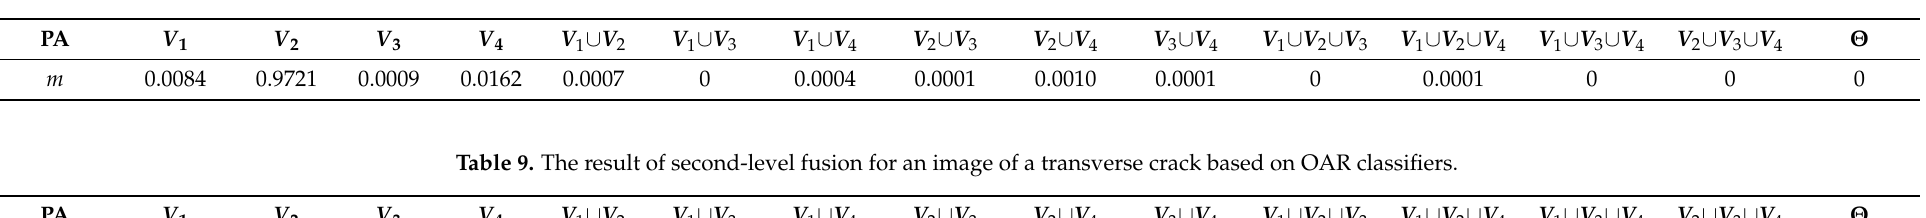
Table 8. The result of second-level fusion for an image of a longitudinal crack based on OAR classifiers.